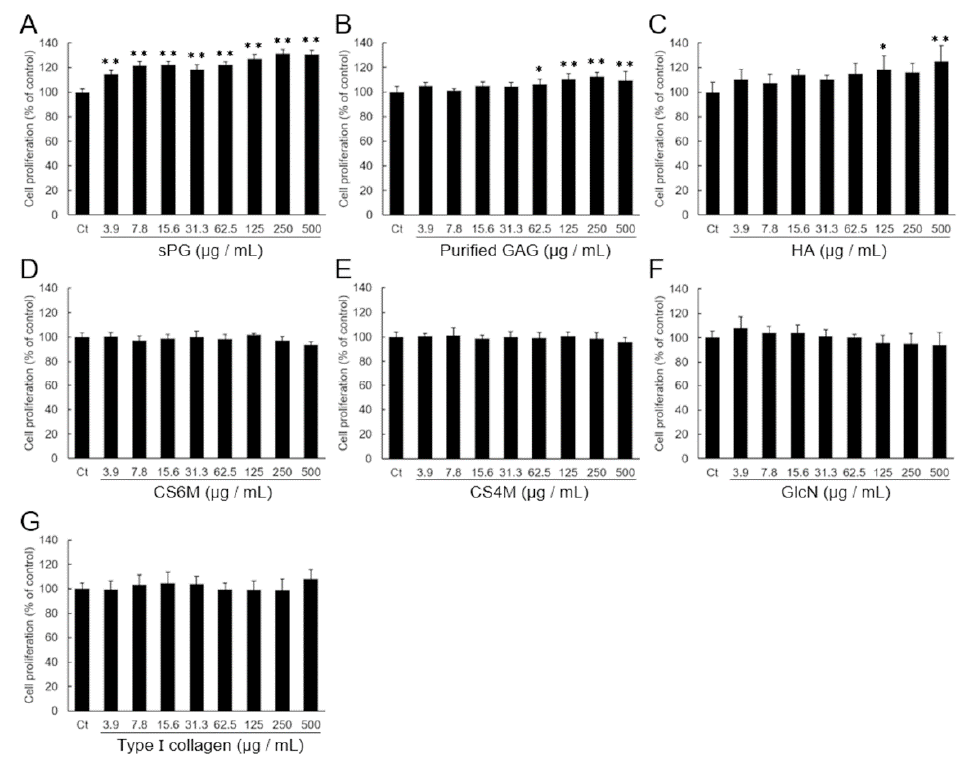
Figure 1. Comparison of cell proliferative effect in extracellular matrix (ECM) components on chondroprogenitor cells ATDC5. Cell growth analysis on the ECM components: aggrecan-type proteoglycan from salmon nasal cartilage (sPG) ( A ), purified GAG ( B ), Glycosaminoglycan from sPG, hyaluronan (HA) ( C ), CS6M ( D ), where 6 sulfate of chondroitin is the major, CS4M ( E ), where 4 sulfate of chondroitin is the major, glucosamine hydrochloride (GlcN) ( F ) and type I collagen ( G ). Proliferative ability of ATDC5 cells was assessed by the WST-8 assay after culturing for 96 h adding to each ECM component (3.9–500 μ g/mL) under DME/F12 medium containing 0.5% FBS without insulin at 37 °C in a humidified atmosphere of 5% CO 2 in air. Control (Ct) is without ECM component. These data are presented as the mean ± S.D. of six replicates. Significant differences show * p < 0.05; ** p < 0.01 vs 0 μ g/mL as control, Dunnett ′ s test.